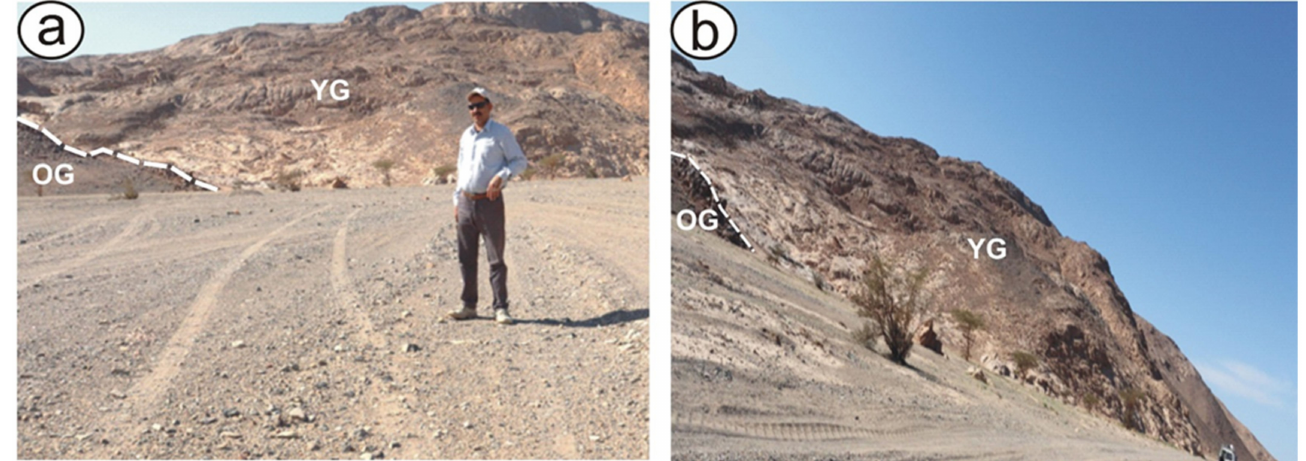
Figure 2. Field photographs showing general views of Homrit Waggat area from its core, revealing the contact between older granitic (OG) rocks and younger granites